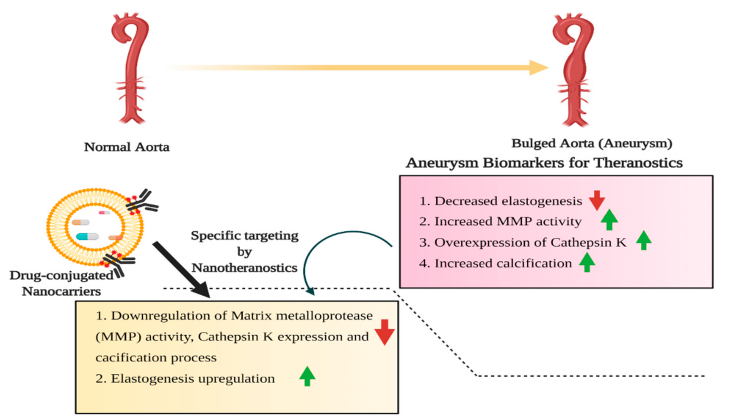
Figure 4. Schematic overview of aortic aneurysms (AA), an important aspect of CVDs and the potential biomarkers considered as a putative target for the diagnosis and therapeutic measures for the management of aneurysms. The localized delivery of doxycycline from PLGA based nanomaterials improved the elastogenesis and strongly inhibited the matrix metalloprotease activity [75]. The charac- teristic therapeutic effect of sustained delivery of doxycycline is achieved through inhib- iting the expression and phosphorylation of the regulatory protein, c-Jun-N-terminal ki- nase 2 (JNK 2) and consequent upregulation of transforming growth factor-beta (TGF- β 1) [76]. In a subsequent study, doxycycline loaded into cationic amphiphile modified submi- cron particles were surface modified with a specific antibody, which acts upon the lyso- somal protease, cathepsin K. Since cathepsin K tend to overexpressed during the growth and progression of AAAs, the spatially designed platforms not only controlled the sus- tained release of doxycycline but also specifically act upon the cathepsin K and thus con- trols the regulation of its expression profile. Thus, the designed particles achieved bi- modal therapeutics by maintaining the elastogenic properties of aortic walls without sys- temic side effects upon release of doxycycline and, on the other hand exhibiting the anti- proteolytic activity by down-regulating the expression of cathepsin K [73]. For therapeutic intervention in targeting the AAAs, it is equally important to diag- nose the growth and pathophysiological changes. Conventional anatomical imaging tech- niques such as Computed tomography (CT), magnetic resonance imaging (MRI), nuclear imaging and optical imaging are widely used for diagnosis. Similarly, coronary artery aneurysms, coronary angiography, intravascular ultrasound, CT angiography, echocardi- ography and coronary MR angiography are regularly used for diagnosis [77]. The limita- tions associated with CT imaging are systemic toxicity (irrational use of iodine and/or gadolinium-based contrasting agents) and the inability to provide exact pathological in- formation about extracellular matrix degradation, which further aggravate the conditions. In this context, optically active, relatively low toxic and exhibiting high absorption co- efficient gold nanoparticles (AuNPs) could be considered as promising alternative con- trasting agents for CT imaging. Due to the tunability for surface modification associated with AuNPs, thus improved the sustained drug delivery at the target sites. The polyeth- ylene glycol (PEG) modified AuNPs not only characteristically improved the imaging quality with in-depth analysis of pathophysiological conditions related to AAAs but also critically reduce the use of contrasting agents, thus minimizing the relative toxicity [78]. Since elastin is considered an important biomarker in the progression of aortic aneurysms, spatially designed nanoparticles targeting the elastin protein could facilitate a new dimen- sion to current knowledge of diagnosis and therapy of AAAs. In this context, elastin-tar- geted AuNPs were formulated as a potential tool for diagnosing aneurysms and thus me- diating the appropriate therapeutic approach [79].